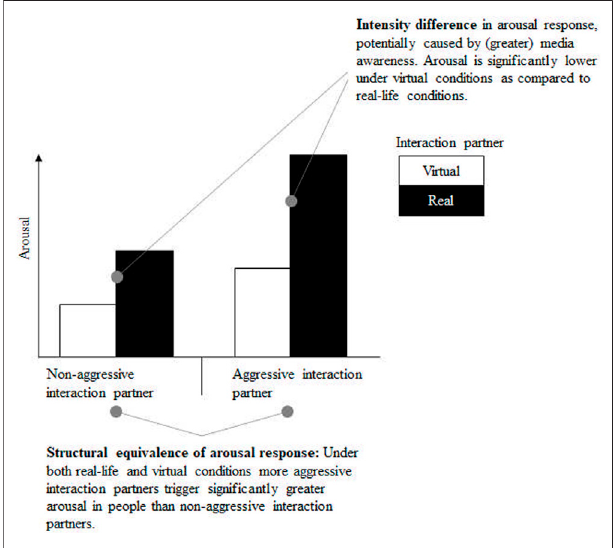
FIGURE 4 | Structural equivalence vs. intensity difference of user responses — illustrated in the context of fi ndings by Blankendaal et al.